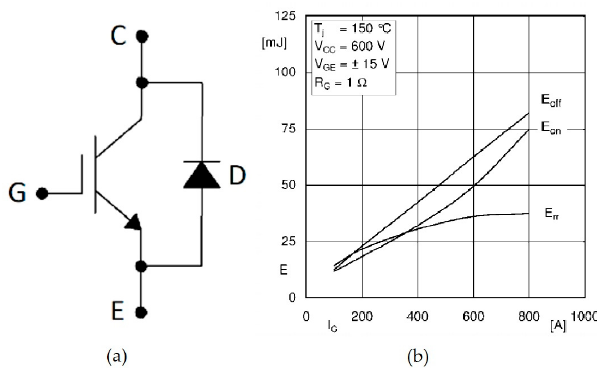
Figure 1. ( a ) Insulated-gate bipolar transistor (IGBT) and anti-parallel freewheeling diode (FWD) module; ( b ) a datasheet graphs example of switching energy losses.